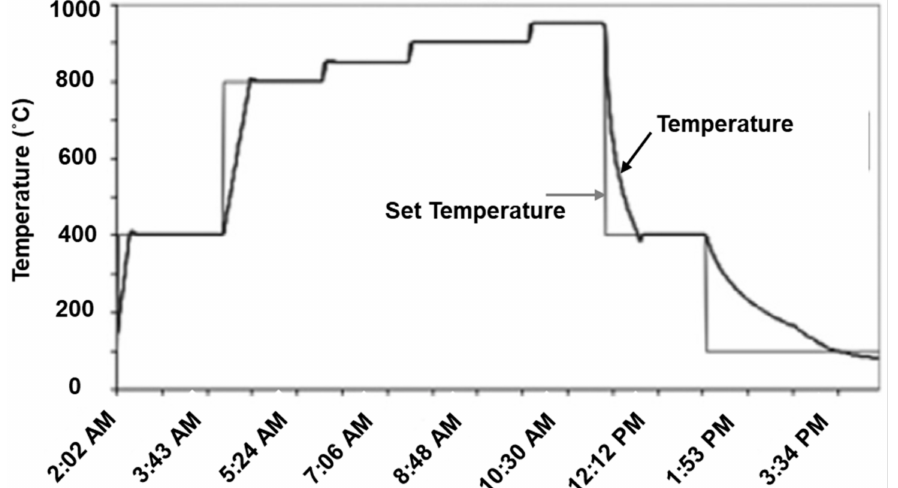
Figure 2. Heating pattern of in situ observation of textures in CP-Ti by HIPPO [4]. The data used in this study are those at 800 ◦ C before transformation, at 950 ◦ C after α -hex → β transformation, and at 400 ◦ C after the heating